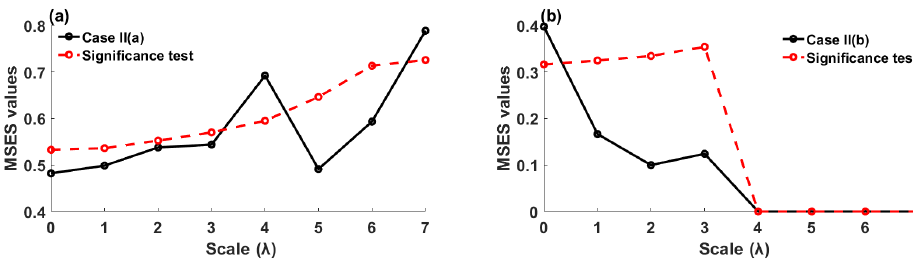
Figure 7. (a, b) MSES and significance level (1%) values at different scales for cases II(a) and II(b). The value at scale 0 is equal to the single-scale ES analysis.